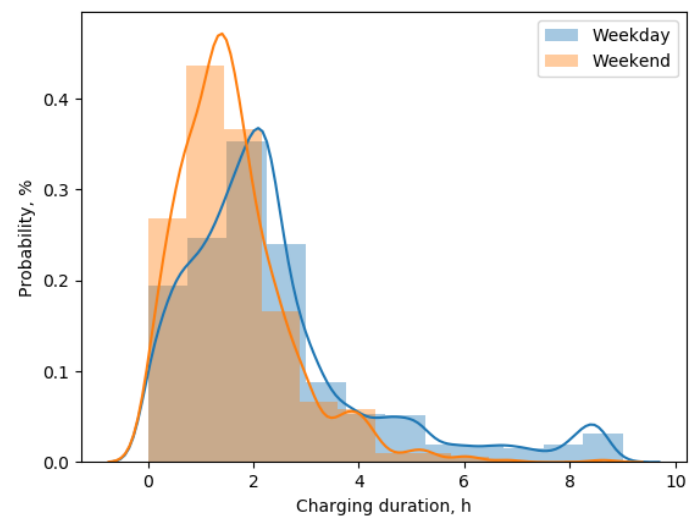
Figure 1. Distribution of charging duration in the dataset for weekdays and weekends after removing the outliers.